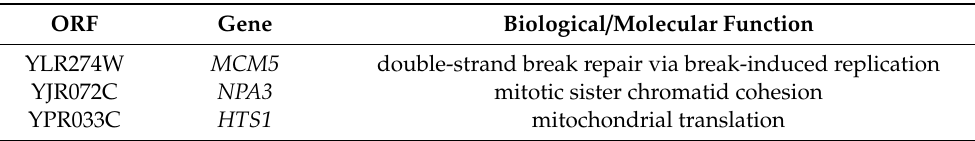
Table 1. Hypersensitive mutants following allicin